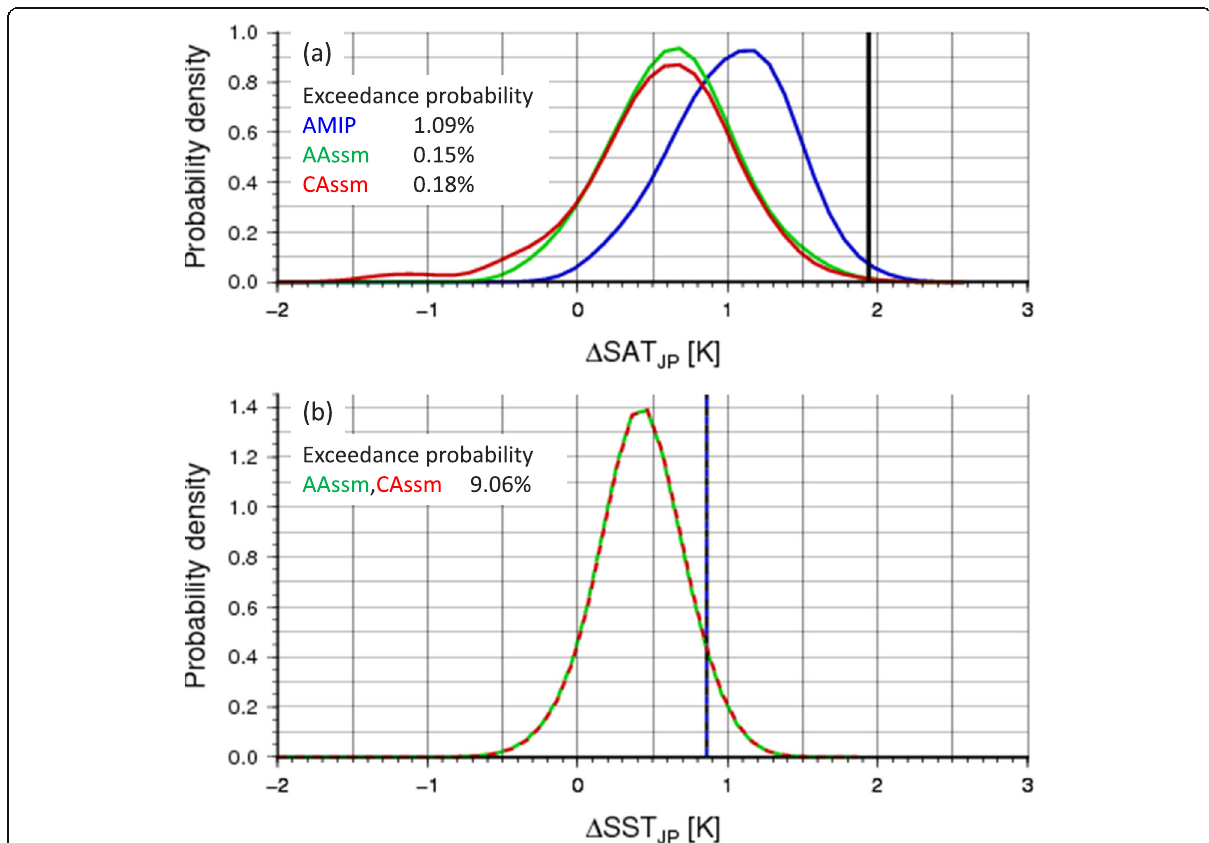
Fig. 6 Probability density functions of a SAT JP and b SST JP anomalies for August 2010 obtained from CAssm (red), AAssm (green), and AMIP (blue) experiments, estimated by the kernel method (Silverman 1986; Kimoto and Ghil 1993). Vertical lines at approximately a 1.94 K and b 0.86 K show the SAT JP and SST JP anomalies obtained from JRA-55 and COBE-SST2, respectively